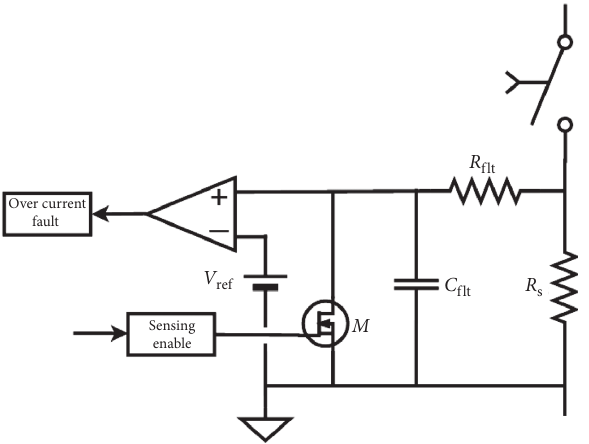
Figure 9: Shunt resistor-based over-current detection.